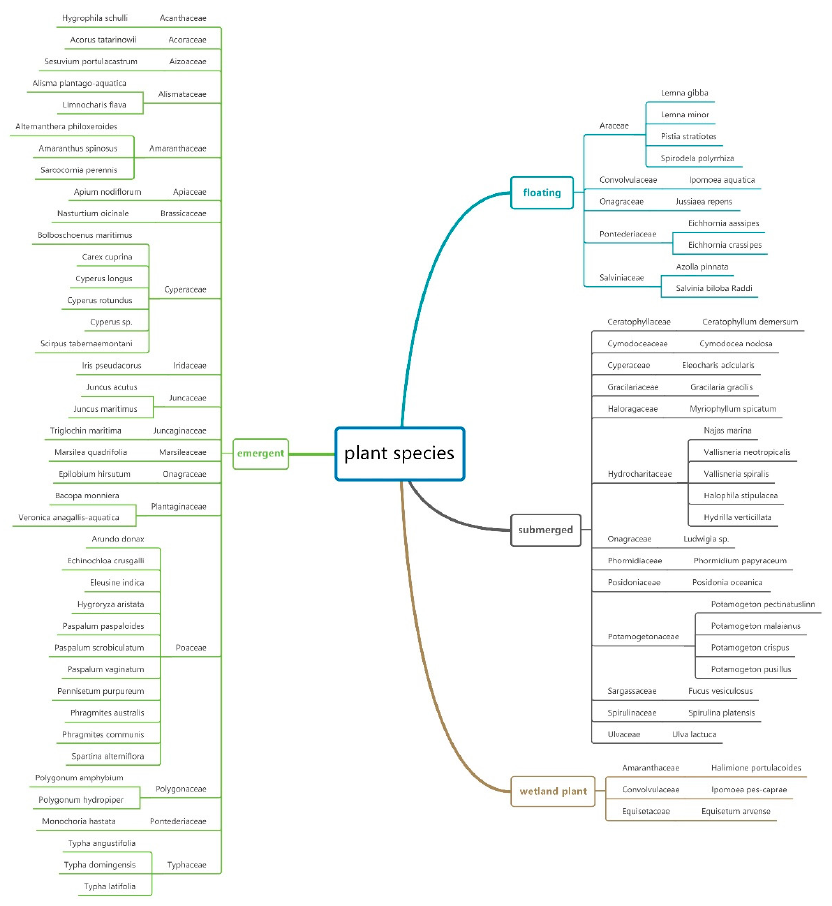
Figure 1. Plant species classification based on the Angiosperm Phylogeny Group III system